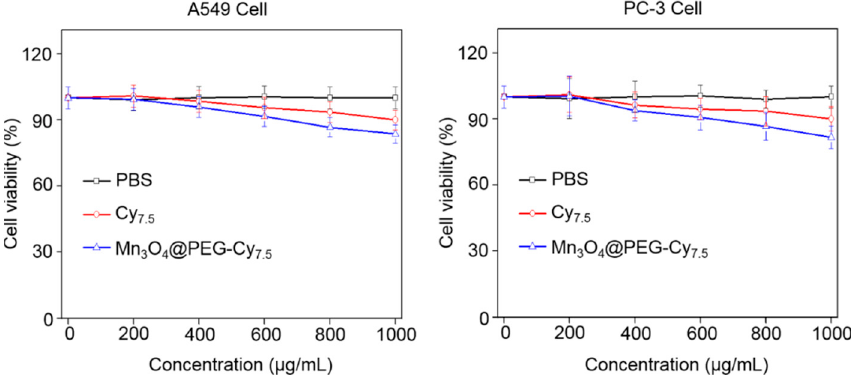
Figure 4. Viability of human breast cancer cells (A549) and human prostate cancer cells (PC-3) incubated with Mn 3 O 4 @PEG-Cy 7.5 NPs at different particle concentrations for 48 h. Blue and red line indicate incubation with NPs and Cy 7.5 , while black are controls. PBS = phosphate-buffered saline.